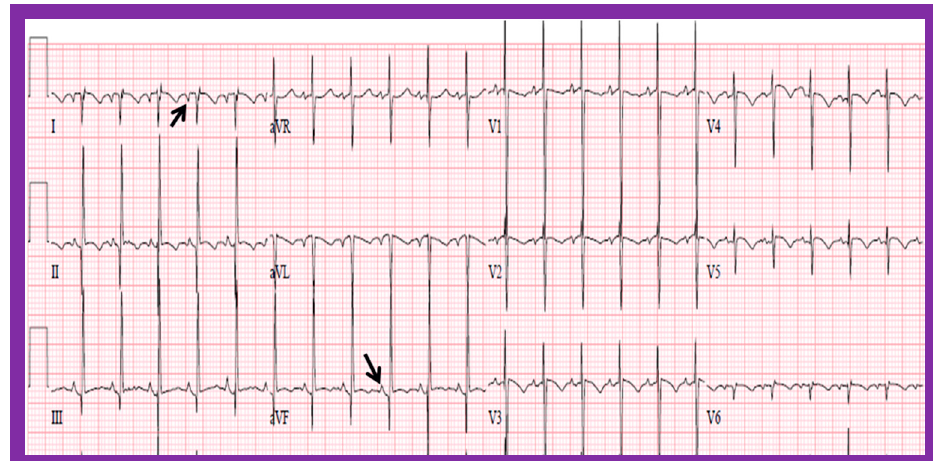
Figure 18. Electrocardiogram (ECG) of a patient illustrating an abnormal vector of the P wave (+135 degrees). The P waves are negative in lead I, while they are positive in lead AVF (arrows). Such a pattern is indicative of situs inversus with a morphologic left atrium on the right side and a morphologic right atrium on the left side. The ECG also shows no Q waves in the QRS complexes of the chest leads; such a pattern is not helpful in localizing the ventricles. Reproduced from reference [4]. If the P waves are negative in lead AVF and positive in lead I (Figure 19), giving an axis is − 45° (Figure 16), it is generally termed low atrial or coronary sinus rhythm. Such a P wave axis is not useful in assessing the situs of the atria. Nevertheless, such coronary sinus (low atrial) rhythms are frequently seen in subjects with infrahepatic interruption of the inferior vena cava (IVC) and persistent left superior vena cava; these venous anomalies are often associated with heterotaxy syndromes (asplenia/polysplenia).